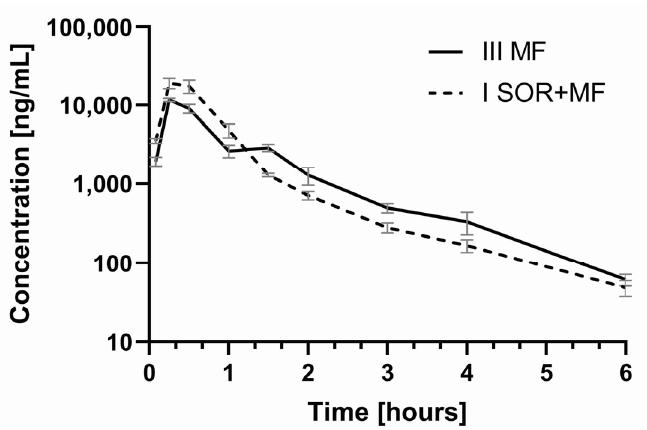
Figure 4. The morphine-3-glucuronide plasma concentration–time profiles in rats receiving mor- phine (III MF ) and sorafenib + morphine (I SOR+MF